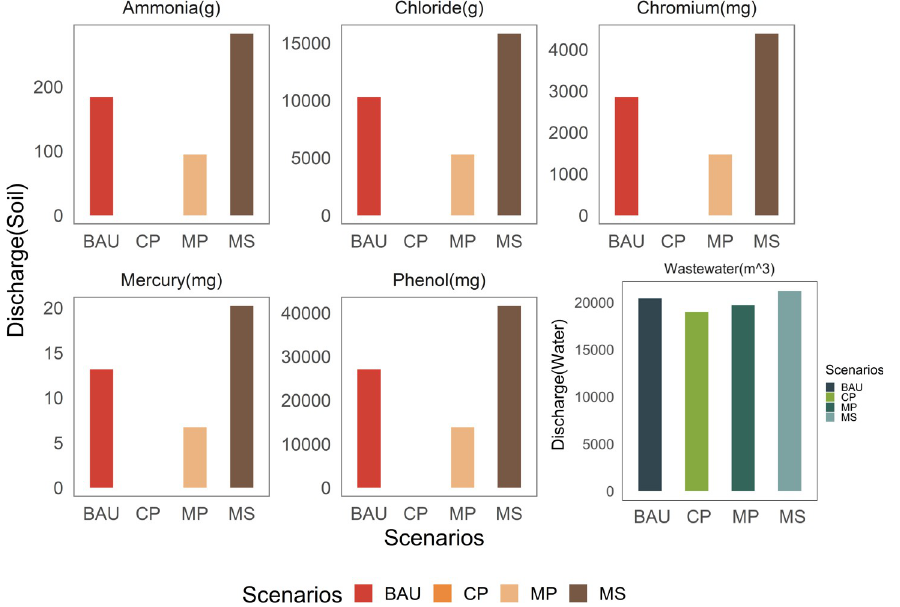
Fig 5. Bar plots showing the wastewater and waste production under four scenarios.